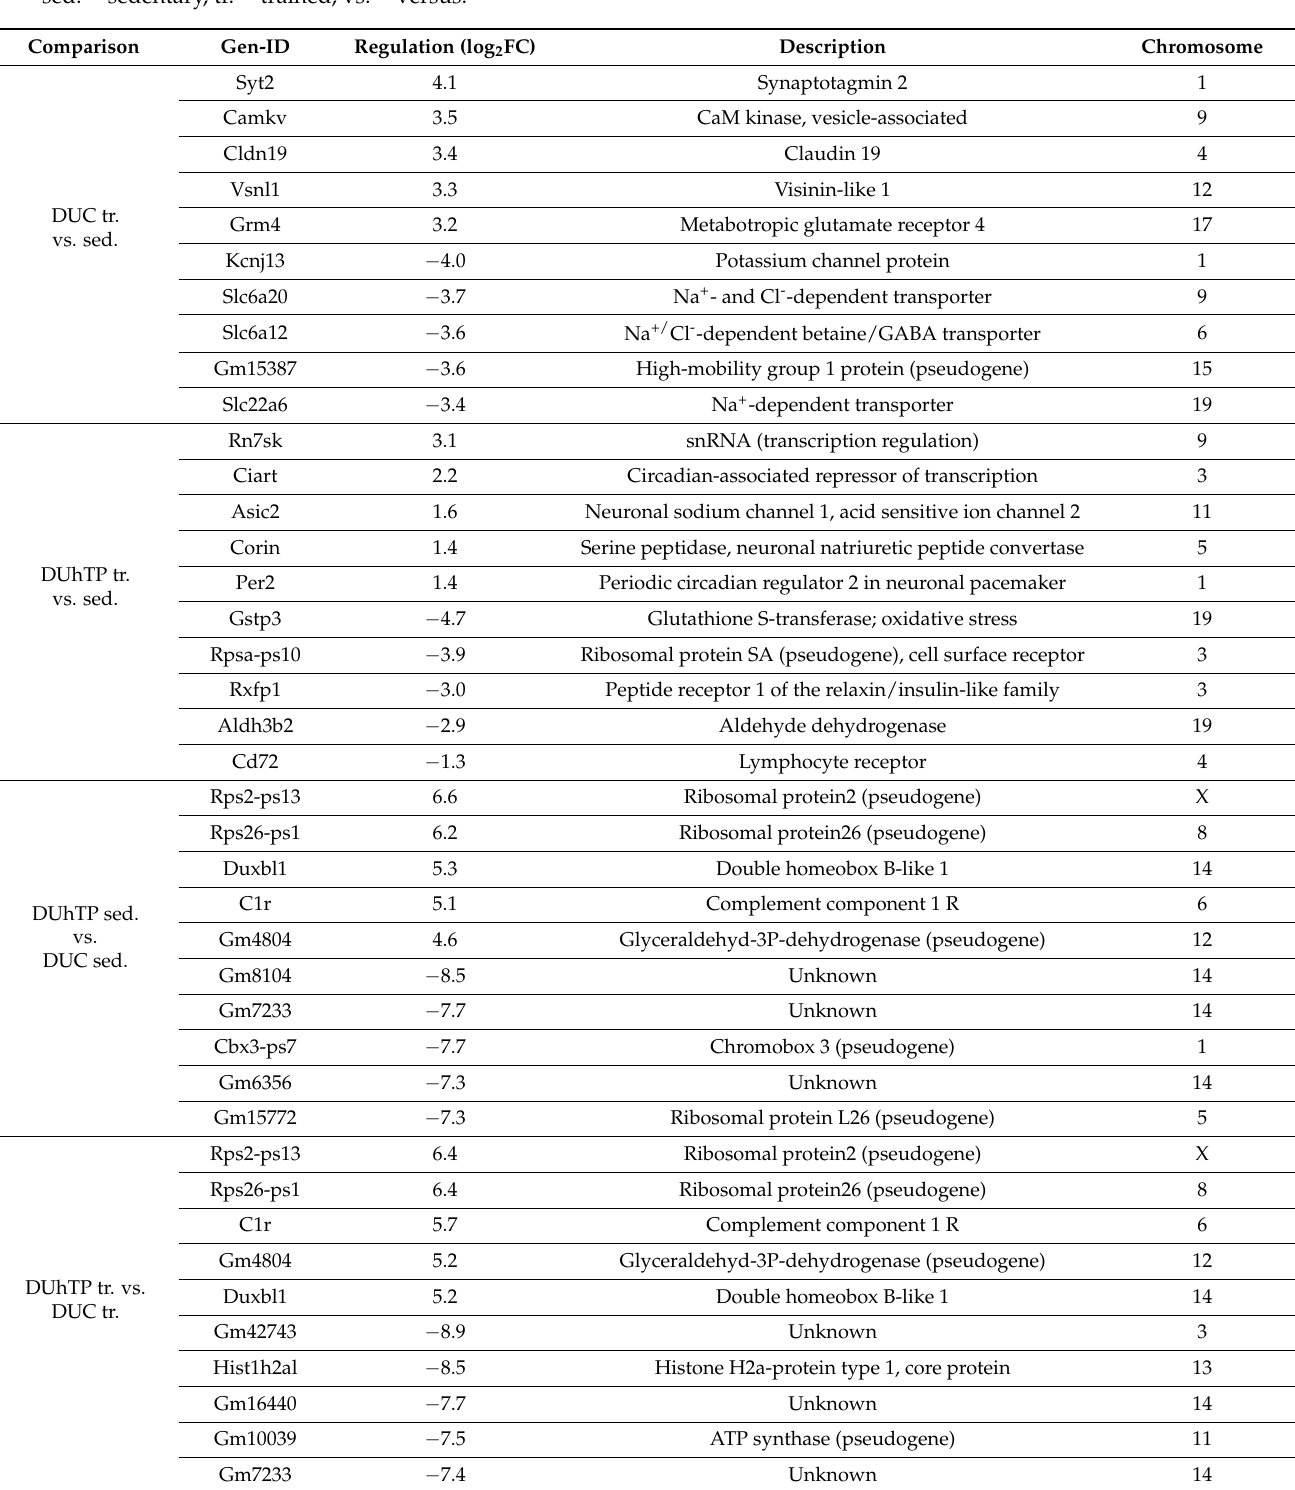
Table 2. TOP5 up- and downregulated genes in all comparison groups. The five most upregulated and five most down- regulated genes are listed with the corresponding regulation intensity and chromosome localization. Abbreviation: sed. = sedentary, tr. = trained, vs. = versus. Comparison Gen-ID Regulation (log 2 FC) Description Chromosome